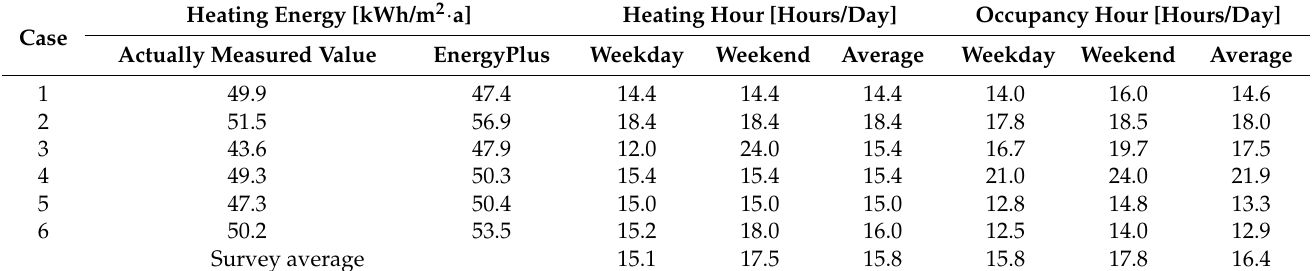
Table 11. Survey results of heating energy, heating hour and occupancy hour (Case 1–6).